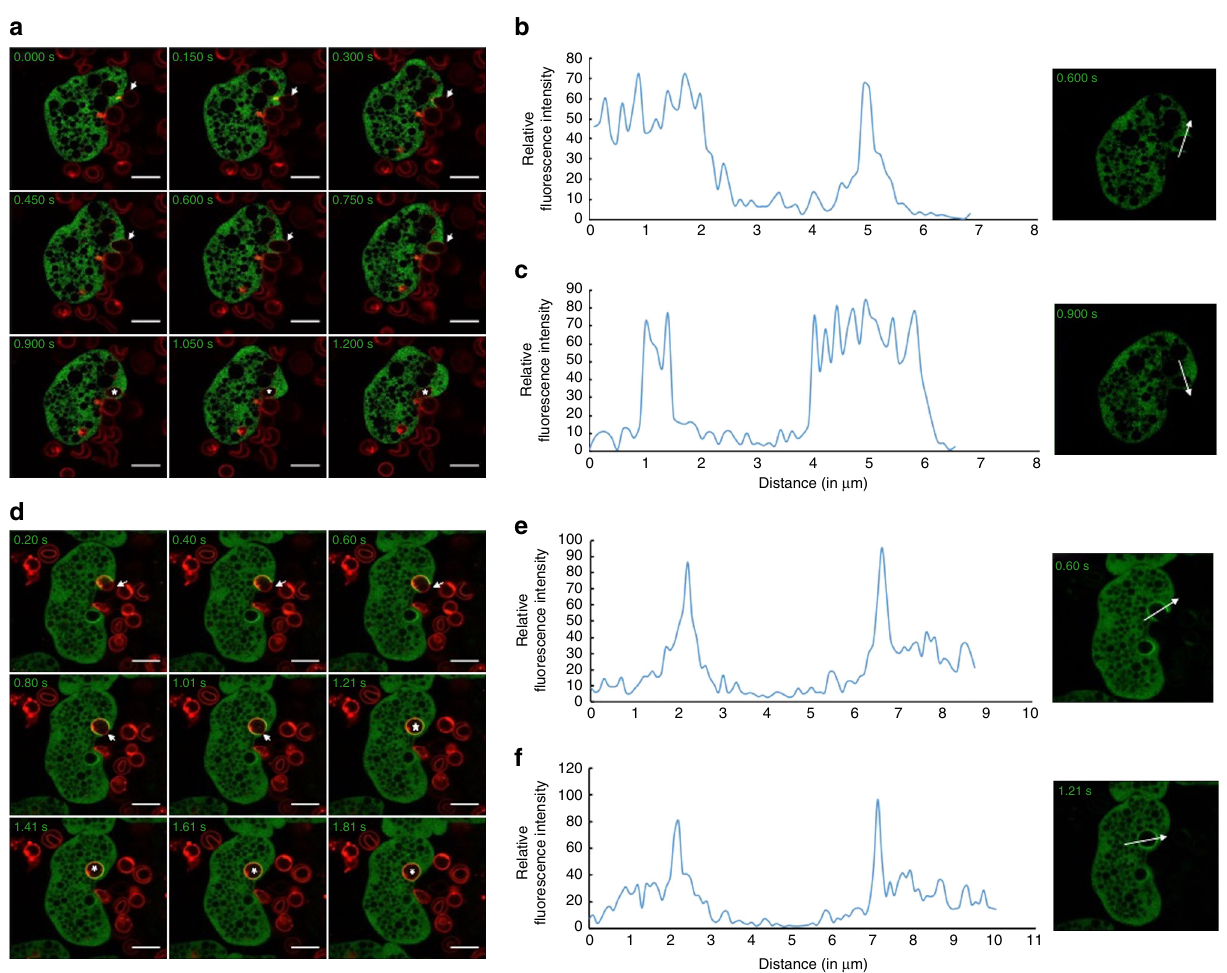
Fig. 6 Time series montage showing localization of GFP-EhAGCK1 and EhAGCK2 during erythrophagocytosis. a The montage of trophozoite expressing GFP-EhAGCK1 engul fi ng labelled human RBC. b , c Analysis of intensity of GFP-EhAGCK1 along the line marked across the phagocytic cup b and newly formed phagosome c . d Montage of a time series of GFP-EhAGCK2 expressing trophozoite undergoing erythrophagocytosis. e , f The intensity analysis of GFP-EhAGCK2 along the line drawn reveals its enrichment in the membrane of phagocytic cups e and newly formed phagosome f . Phagocytic cups are marked by arrow and internalized RBCs in new phagosome are marked by asterisk . ( Scale bar , 10 μ